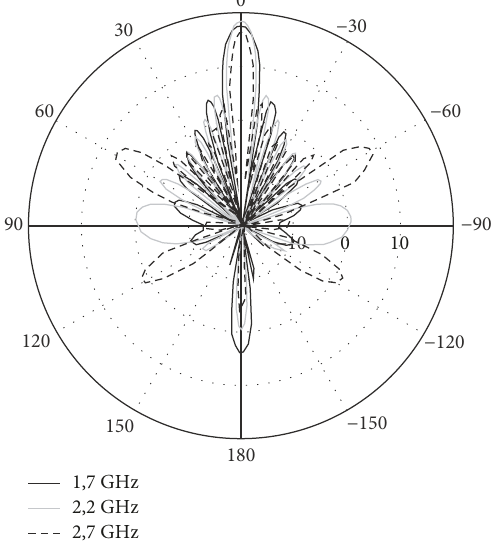
Figure 7: Simulated radiation patterns of eight-element linear array at 1.7, 2.2, and 2.7 GHz with 128mm element spacing in 𝑦 -axis. The radiation is presented in phi = 90 deg as a function of